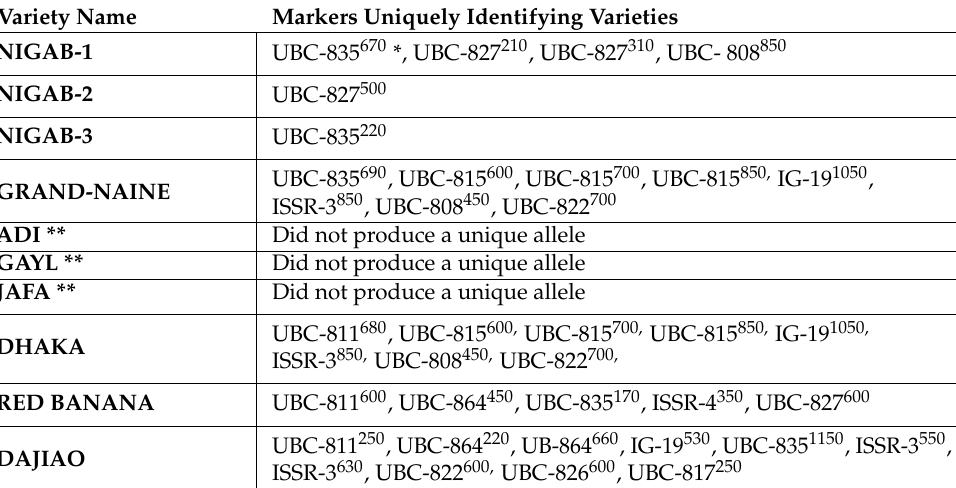
Figure 4. Electropherogram of 14 banana varieties amplified by ISSR markers—M = 1 kb plus DNA ladder, Variety order (1 to 14 from left to right), 1 = NIGAB-1, NIGAB-2, NIGAB-3, Grand Naine, Adi, Gayl, Jafa, Dhaka Red Banana Dajiao, Basrai, Sprout-1 and Sprout-2, 15 = Actin (positive control gene present in a banana), 16 = negative control. White-colored arrows indicate uniquely identified polymorphic bands in eleven banana varieties. ( A ) ISSR marker UBC-815 uniquely identified Grand Naine, Dhaka, and Sprout-1 with band sizes 600, 690, 700, and 850 bp. ( B ) ISSR marker UBC-811 uniquely identified Dhaka, Red banana, Fenjiao, Dajiao, and Sprout-1 with band sizes 250, 390, 290, 420, 480, and 620 bp. ( C ) ISSR marker UBC-864 uniquely identified Red banana, Fenjiao, and Dajiao with band sizes 220, 300, 450, 660, 840, 850, and 950 bp. ( D ) ISSR marker IG-19 uniquely identified Grand-Naine, Dhaka and Fenjiao with band sizes 530, 850, and 1050 bp. ( E ) ISSR-4 markers uniquely identified Red Banana, Fenjiao, and Sprout-1 with band sizes 350, 900 and 1400 bp. ( F ) ISSR marker UBC-835 uniquely identified NIGAB-1, Grand-Naine, Red banana, Dajiao, and Fenjiao with band sizes 170, 220, 670, 690, and 1000 bp. Table 3. Summary of ISSR markers uniquely identifying the banana varieties of